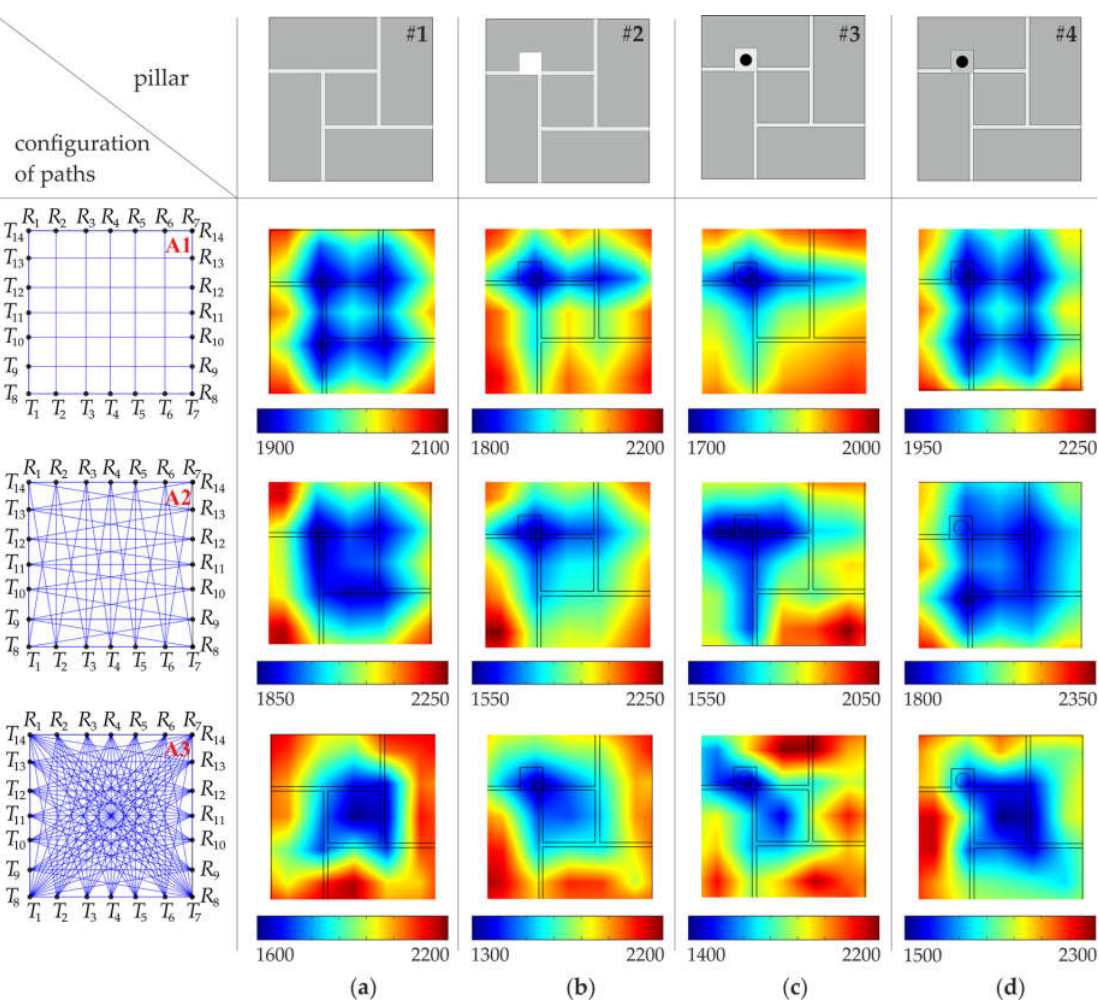
Figure 9. Tomographic velocity images (values in (m/s)), with a division into 49 pixels (configuration #A), obtained from experimental signals: ( a ) intact pillar; ( b ) pillar with the square hole; ( c ) pillar with the steel bar grouted by means of gypsum mortar; ( d ) pillar with the steel bar grouted by means of cement mortar.